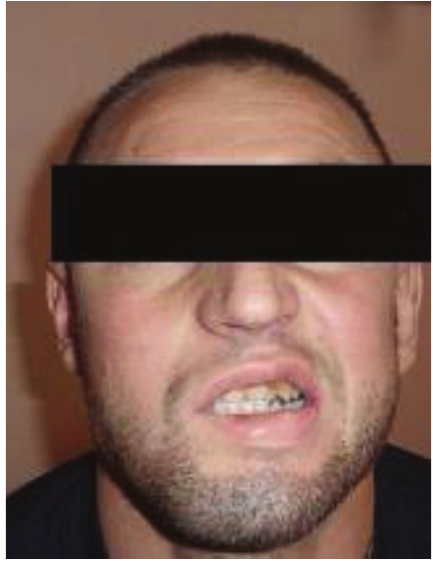
Figure 1: Unilateral right peripheral nerve palsy.